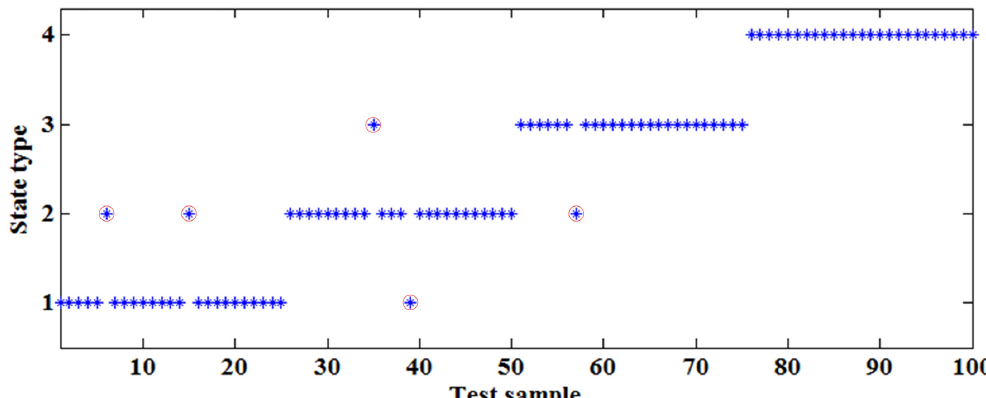
Figure 9. Comparison between actual state and the proposed method. Blue points mean the samples are classified correctly, blue points with red circle mean the samples are misjudged into other cutting pattern.